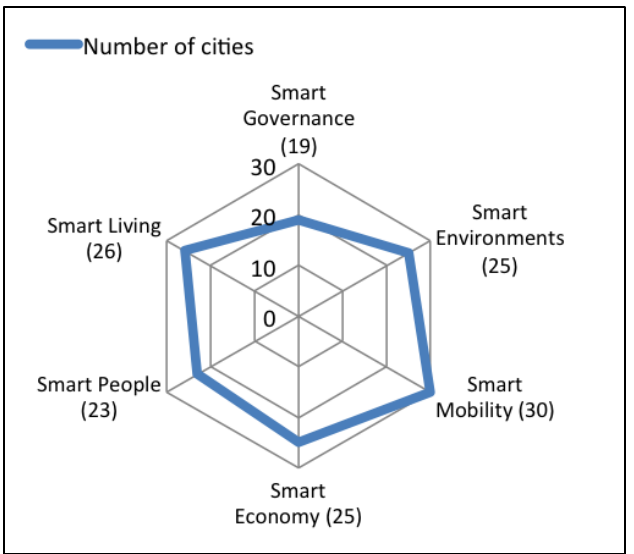
Figure 5. Usage of data driven smart city applications according to smart city indicators and evaluation criteria.